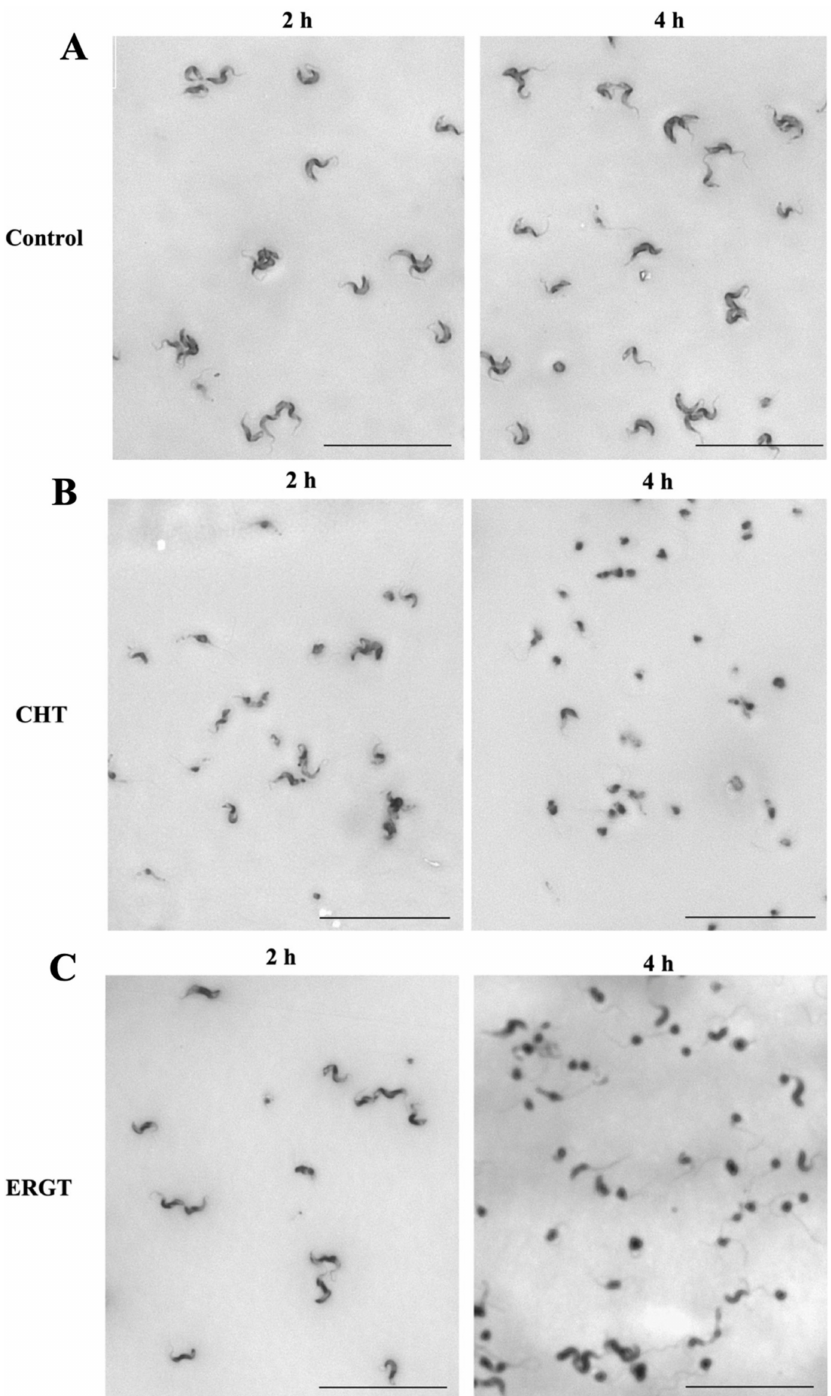
Figure 3. Effect of CHT/ERGT treatment on cell morphology. T. brucei BF cells (1 × 10 6 /mL) were incubated with CHT and ERGT at their respective 5 × EC 50 concentrations. Untreated control cells were used in parallel ( A ). At different time points (2 and 4 h) cells (100 µ L of the culture) were harvested, spread on microscope slides, and stained with Giemsa solution. Images were taken with a Keyence phase-contrast microscope using 40 × objective. A major change in morphology was observed for cells treated with CHT ( B ) and ERGT ( C ) at 4 h time point. Experiments were repeated three times and multiple areas on the slides were observed for each sample. Scale bars represent 50 µ